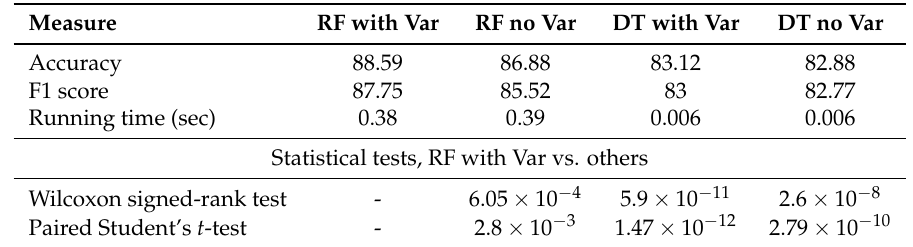
Table 2. Classification results, running time and statistical tests for the proposed approach against other setups, including decision tree (DT) without variance [4] in the last column.